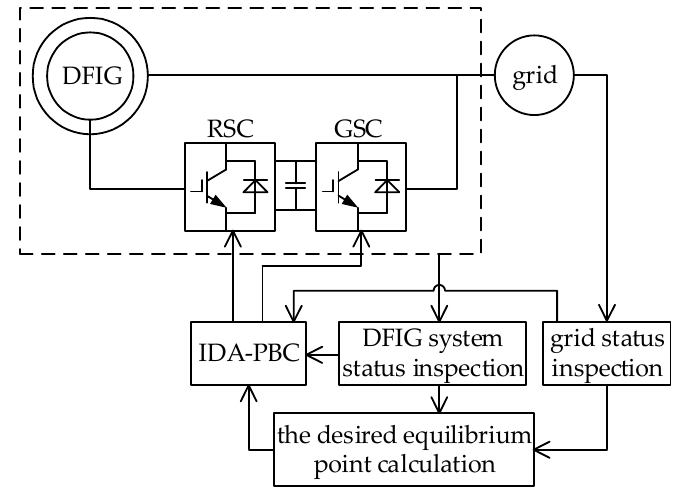
Figure 1. Structure scheme of doubly fed induction generator (DFIG) system with IDA-PBC method. By status inspection of the grid and the DFIG system, real-time state variables of the grid and